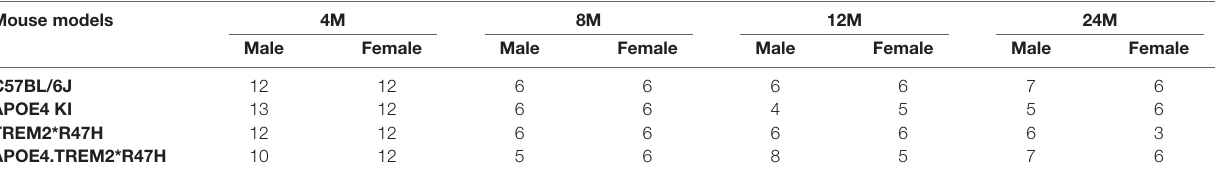
TABLE 5 | RNA-seq study population. Mouse